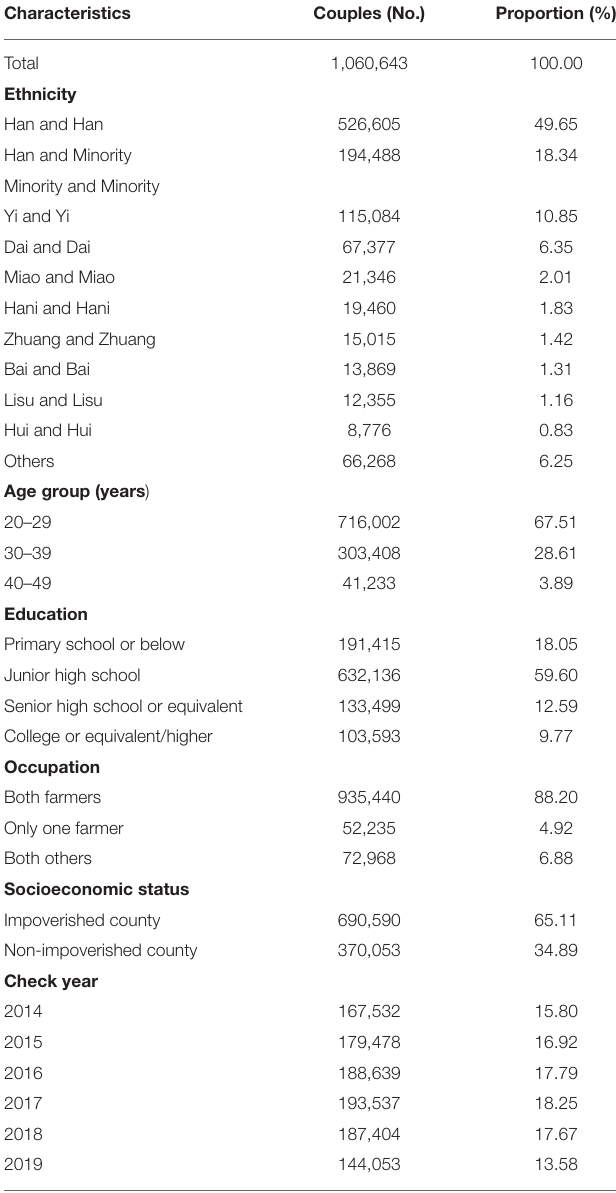
TABLE 1 | Sociodemographic characteristics of the included reproductive-age couples. Characteristics Couples (No.) Proportion (%) Total 1,060,643 100.00